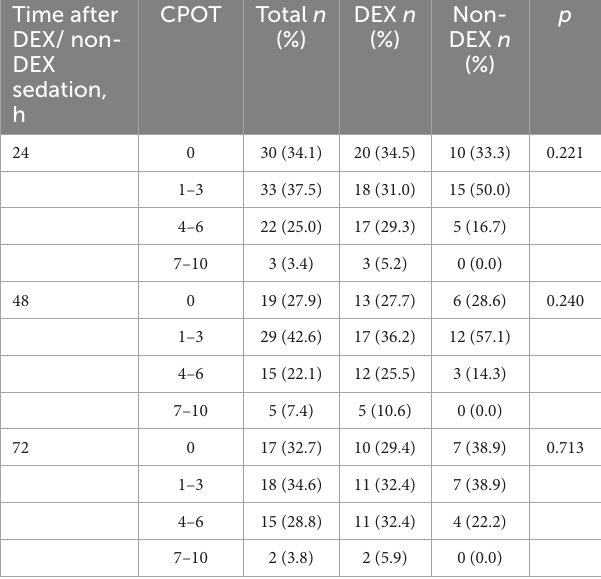
TABLE 2 The critical care pain observation tool (CPOT) at the timepoint of 24 h, 48 h, and 72 h after DEX/non-DEX administration. Time after DEX/ non-